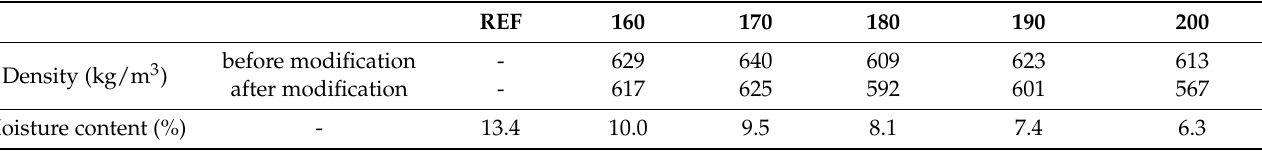
Valid N = 30 for all properties. * From all samples before heat treatment. REF = reference, with no treatment. Modification: 160 = heat treatment at 160 ◦ C; 170 = heat treatment at 170 ◦ C; 180 = heat treatment at 180 ◦ C; 190 = heat treatment at 190 ◦ C; 200 = heat treatment at 200 ◦ C. Table 3. Mean values of density and equilibrium moisture content of thermally modified birch wood after air conditioning (RH = 65 ± 5%, t = 20 ± 2 ◦ C).